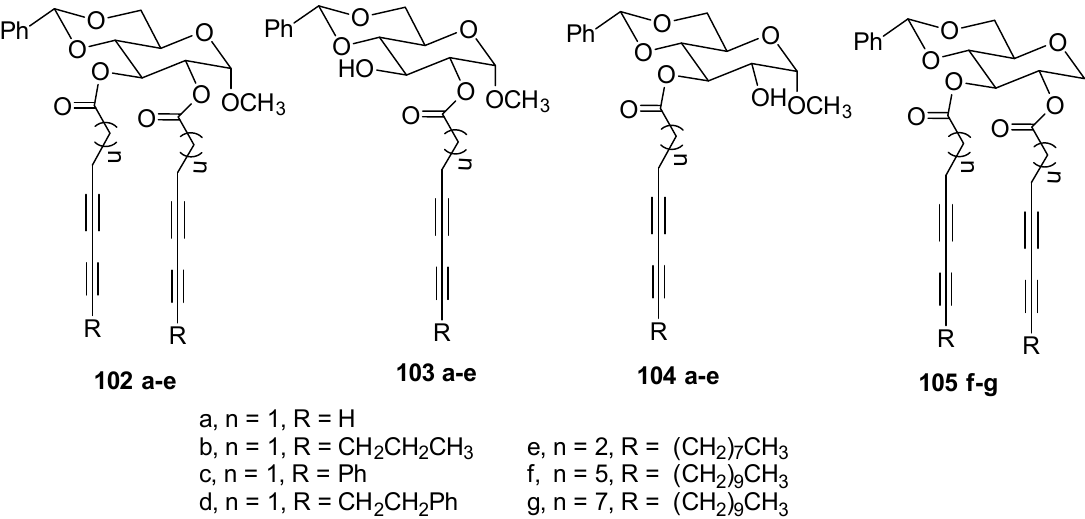
Figure 60. Structures of diacetylene containing glycolipids from D-glucose [30,31], n is the number of repeating CH 2 .